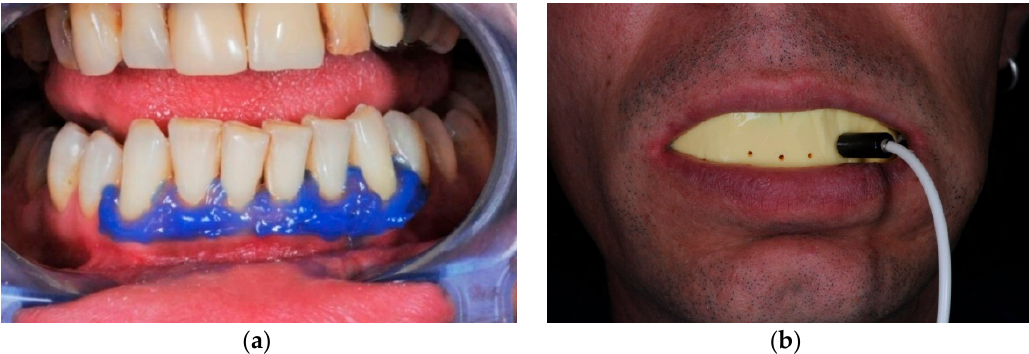
Figure 4. Laser-Doppler flowmetry (LDF) recording process: ( a ) periodontal liquid dam as gingival barrier applied around every tooth; ( b ) position of the impression with the LDF probe. Int. J. Environ. Res. Public Health 2020 , 17 , x